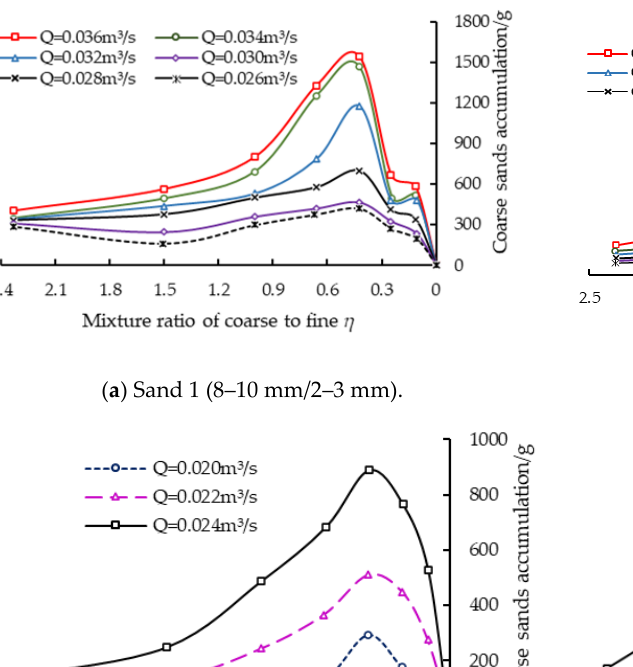
G and mixture ratio η under various bm